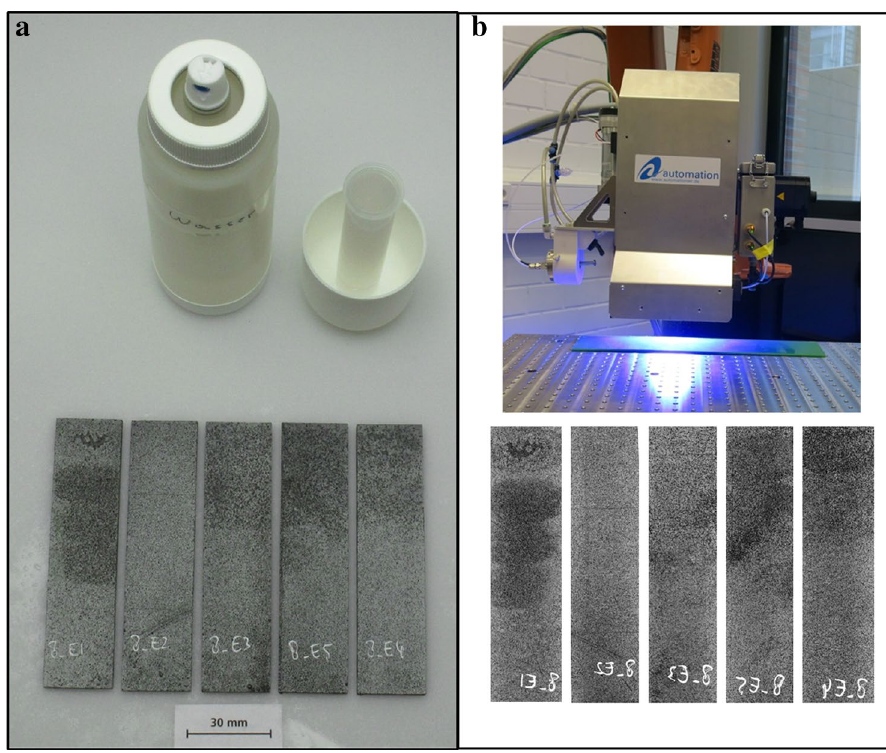
Fig. 9 Droplet patterns on the same black R-ABS substrates as shown in Fig. 8 obtained after a manual water spraying using the displayed aerosol can and b applying the dis- played robot-aided automated AWT